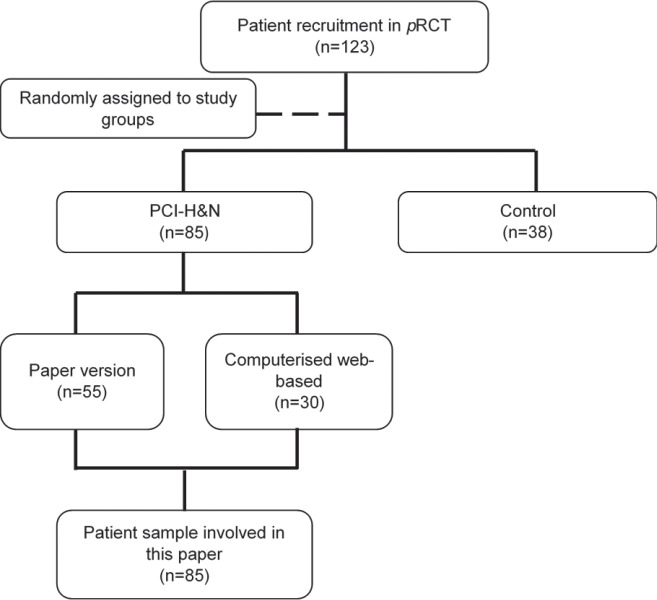
Post-treatment oral cancer patients involved in this paper (n = 85).